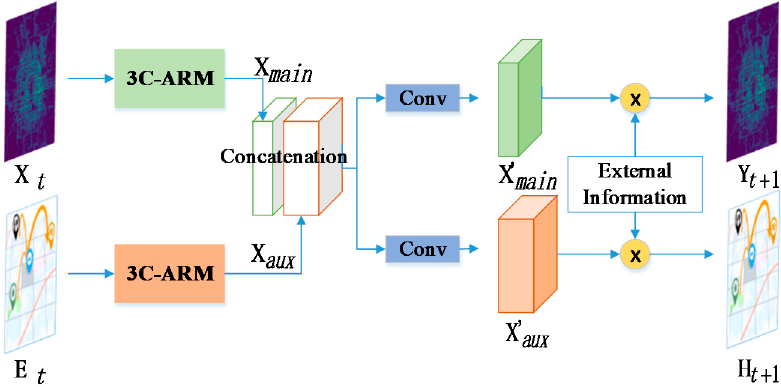
Figure 7. Our fusion strategy under the multi-task framework. The “3C-ARM” component represents the Attention mechanism, Residual connection and Multi-scale convolution within three temporal Channels. The output of “3C-ARM” is denoted as X main and X aux , then we fuse them in a concatenated way, after which a convolution layer is appended to obtain the respective measurements X(cid:48) main and X(cid:48) aux of the two tasks. Finally, we feed them with our proposed external information ℰ (cid:3047)(cid:3020) to a fully connected layer, respectively, to obtain the final results Y t + 1 and H t + 1